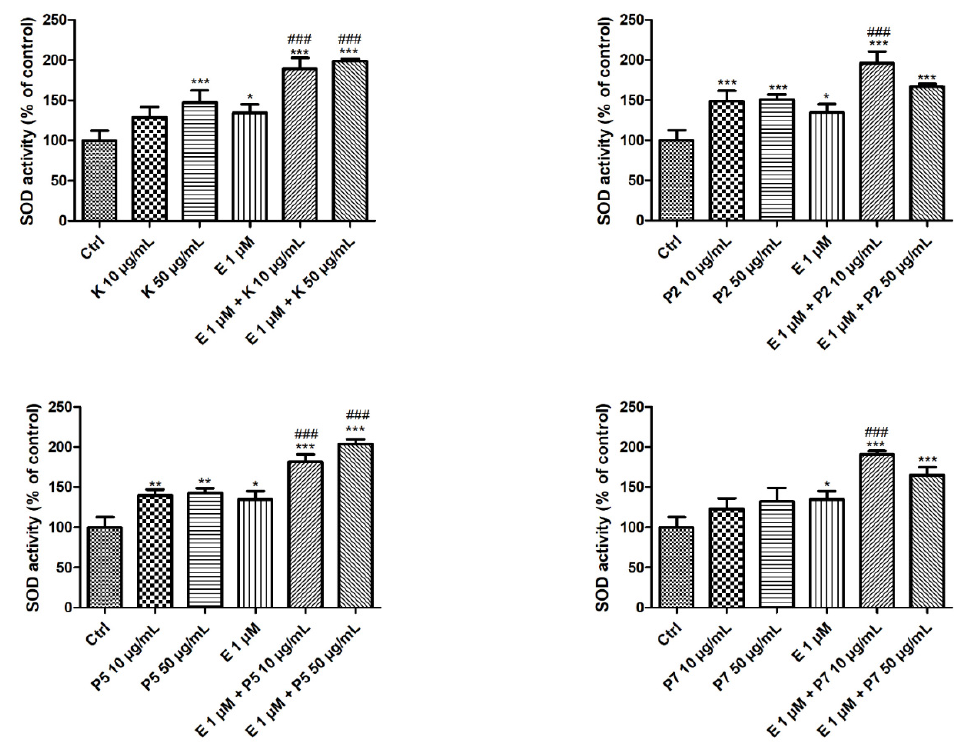
Figure 2. Superoxide dismutase activity in HL-60 cells incubated for 24 h at 37 ◦ C with 10–50- µ g/mL kaempferol (K), P2, P5, P7, and/or 1- µ M etoposide (E). The figure shows the mean results ± SD, n = 3; * p < 0.05, ** p < 0.01, and *** p < 0.001 vs. control (Ctrl); ### p < 0.001 vs. etoposide € . Data were normalized to the negative control, which was assigned as 100% of the SOD activity.